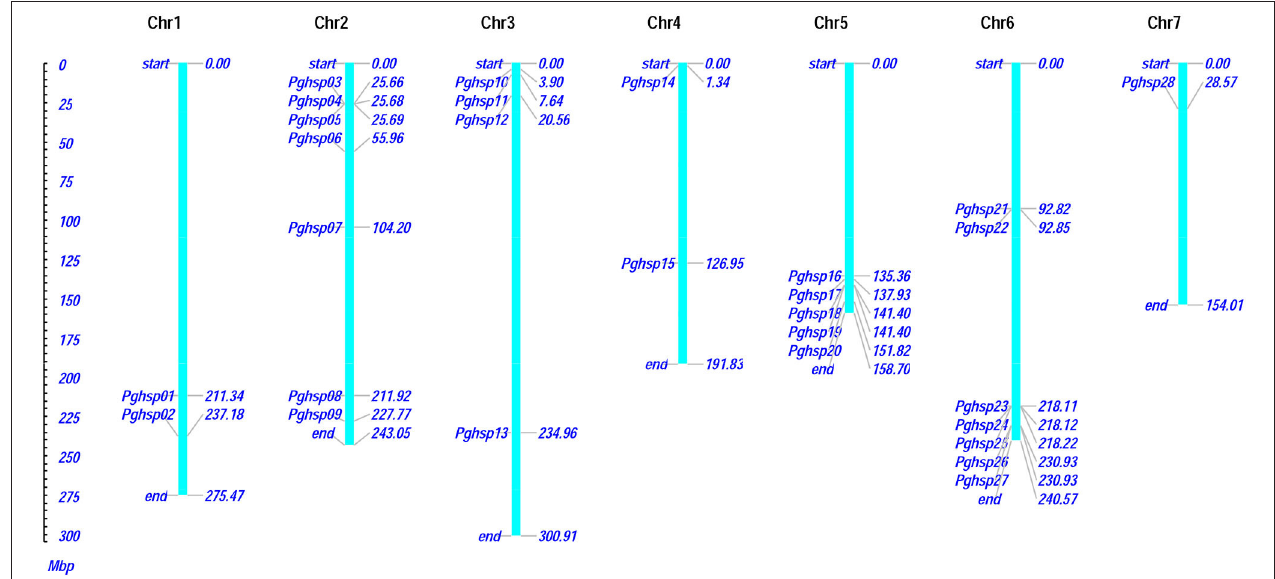
FIGURE 6 | The chromosomal distribution and positioning of PgHSP20s across all seven chromosomes of pearl millet. Seven chromosomes with varying lengths are shown in the million base pair (Mbp) scale in the left, where the chromosome (represented in bars) is marked by the respective genes with its genomic position (https://figshare.com/s/d113cd59ea02544c8825).